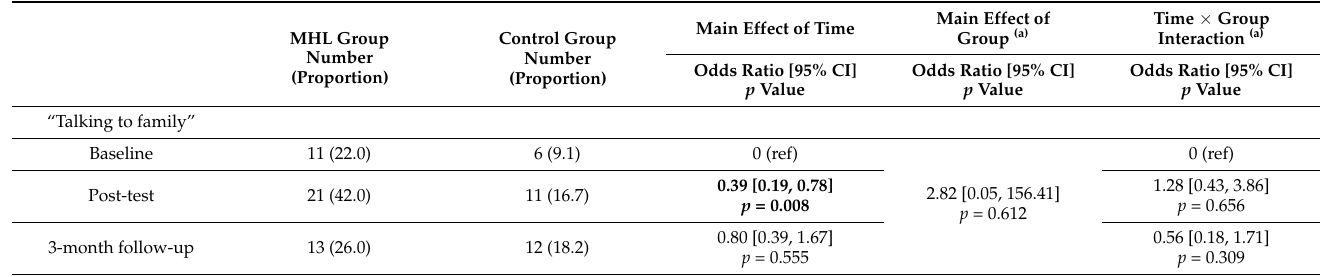
Table 4. Effects of MHL group and control group on behaviour